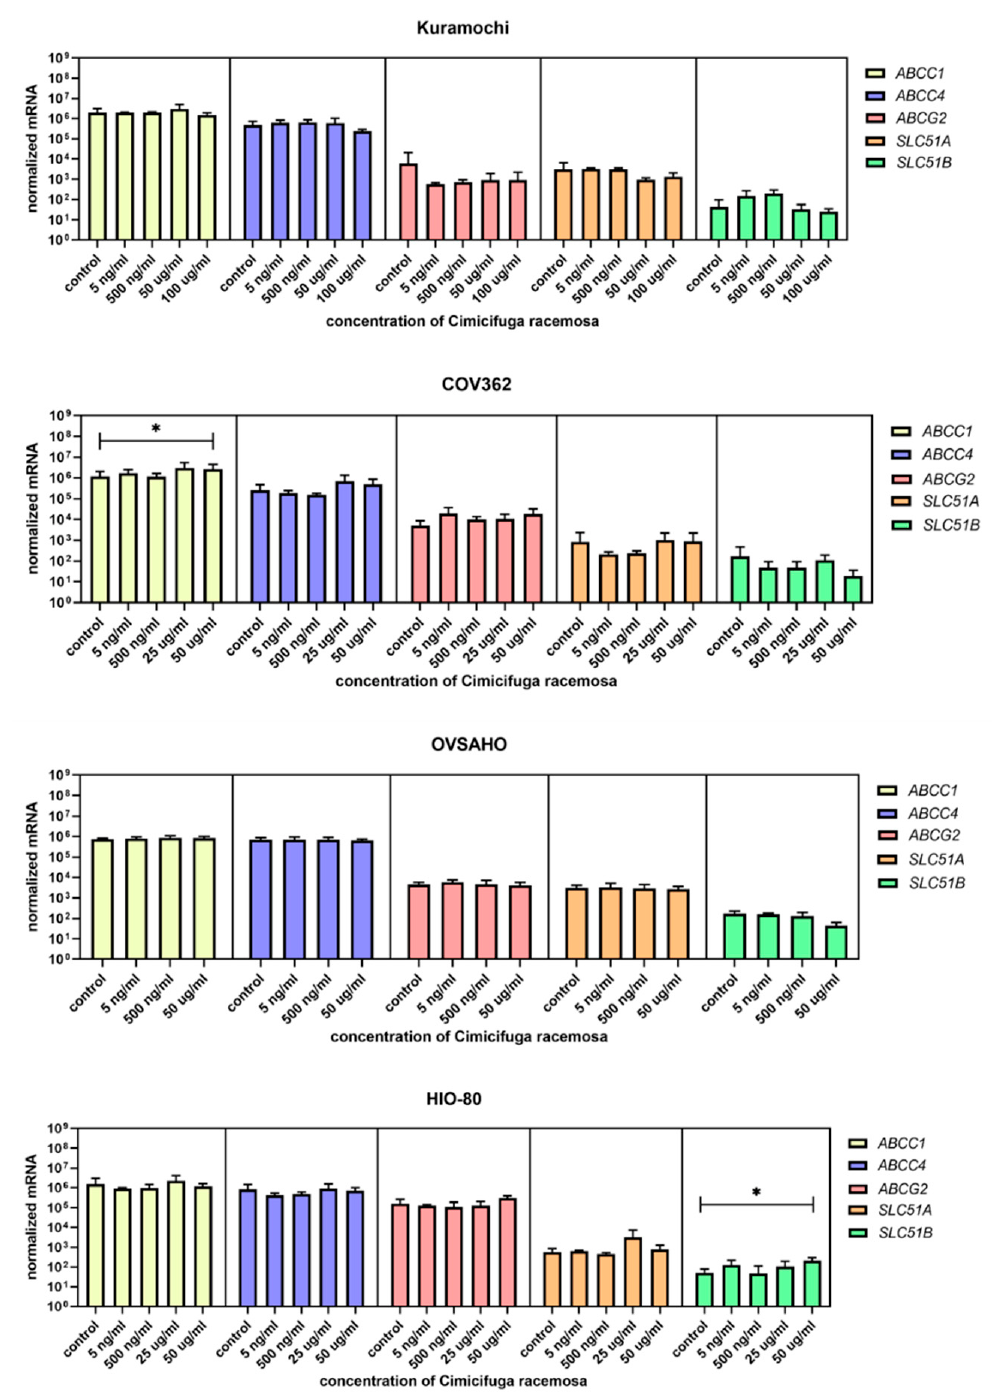
Figure 10. Normalized expression of five different genes of efflux ( ABCC1 , ABCC4 , ABCG2 , SLC51A , SLC51B ) in the ovarian cancer cell lines Kuramochi, COV362, and OVSAHO and control cell line HIO-80. At least three independent experiments were performed. Data are shown as mean ± SD. * p -value ≤ 0.05.